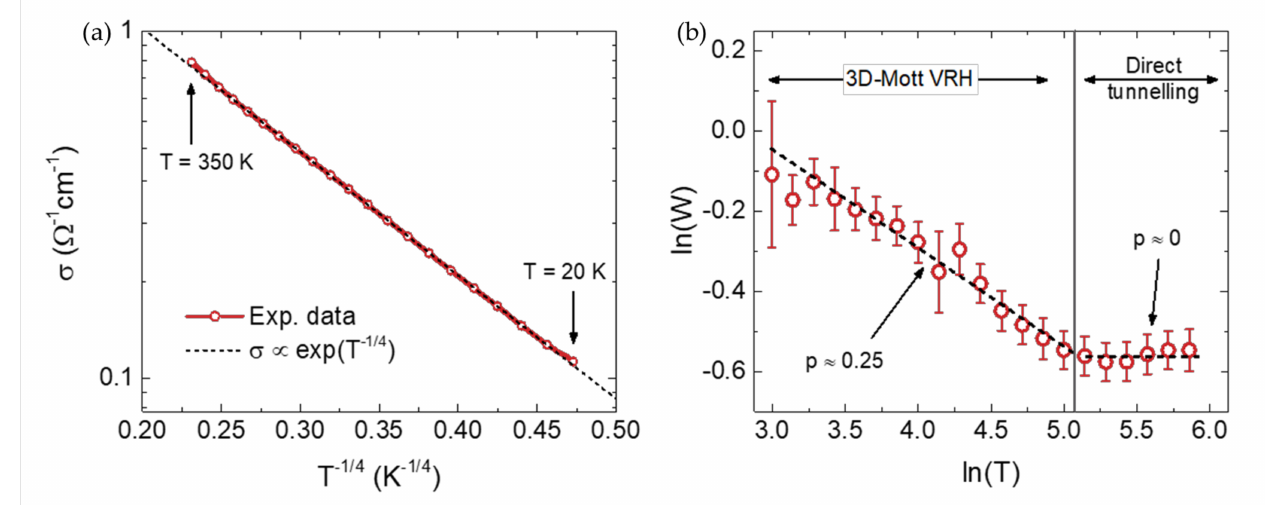
Figure 3. ( a ) DC electrical conductivity σ of WCB as a function of T − 1/4 in semilogarithmic scale between 350 K and 20 K. Dashed line is the ideal scaling expected for 3D Mott variable range hopping conduction. ( b ) Reduced activation energy W = d ( ln σ ) / d ( ln T ) as a function of temperature in bilogarithmic scale. Dashed lines are linear fits to the data in the ranges where σ is dominated by 3D Mott VRH ( T ≤ 165 K) or direct tunnelling between sp 2 domains ( T ≥ 165